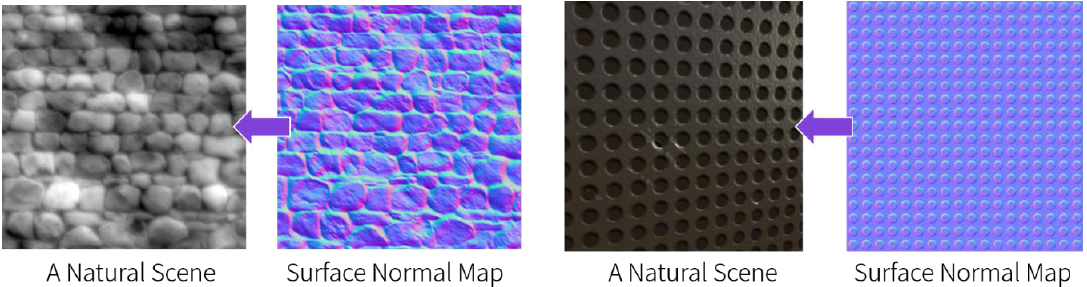
Figure 5. Surface normal map-to-natural scene mapping example.